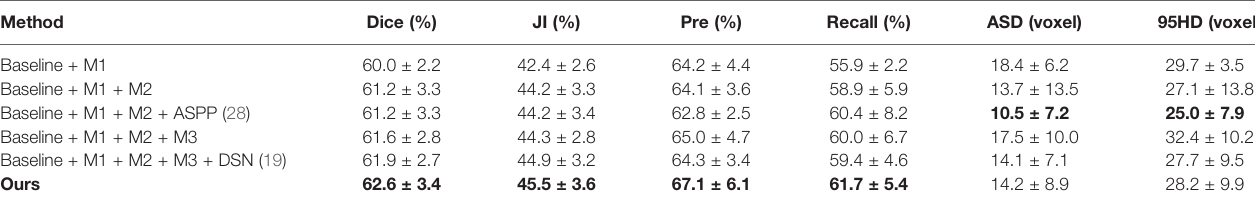
TABLE 2 | Automatic segmentation results of ablation analyses.